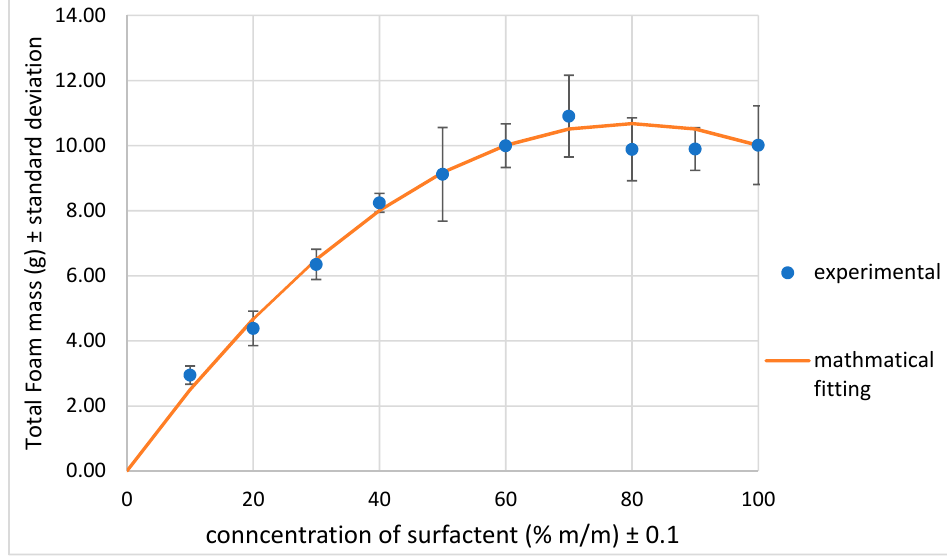
Figure 5. Total amount of foam generated for each concentration of surfactant fitted according to Equation (2) with M min = 10.01, c max = 0.8 [8].